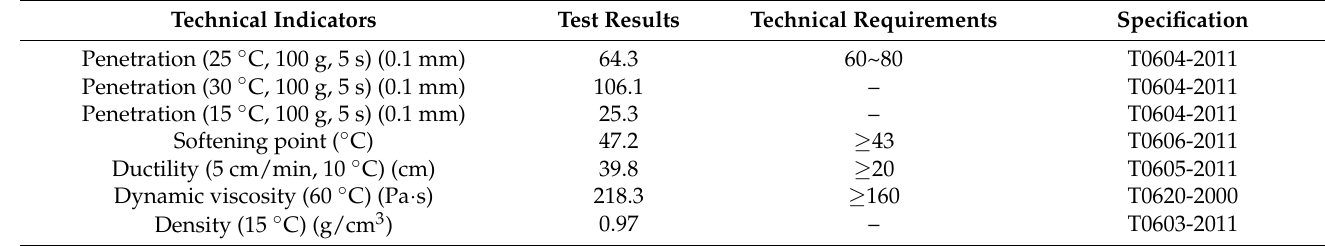
Table 1. Basic performance test results of matrix asphalt.